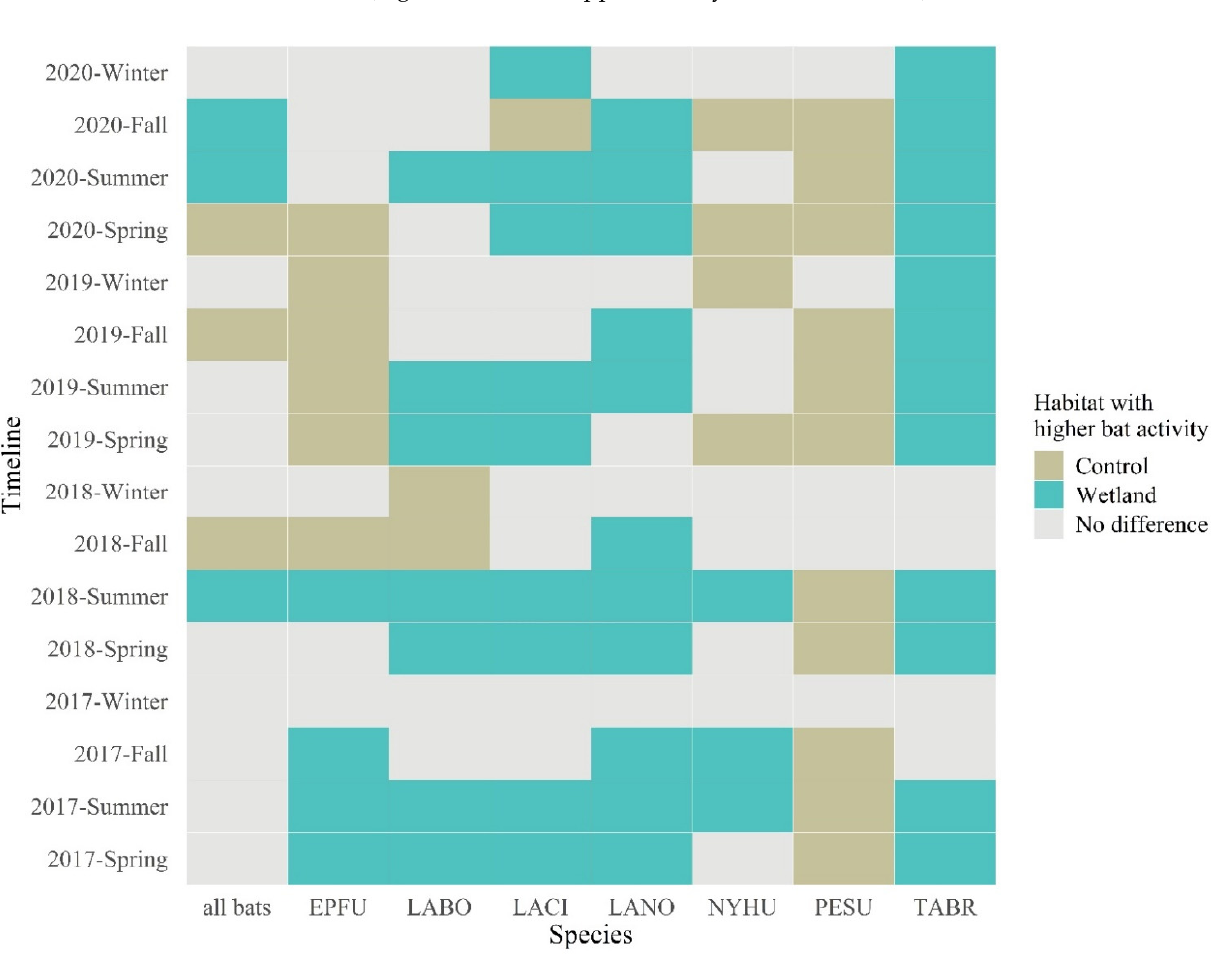
Figure 1. Tile plot showing in different seasons whether the open wetland or the open control had higher total and species- specific bat activity in the Peabody Park in Greensboro, North Carolina, USA. Statistical significance was determined by Wilcoxon tests. Species abbreviations in all figures: EPFU, Eptesicus fuscus ; LABO, Lasiurus borealis ; LACI, L. cinereus ; LANO, Lasionycteris noctivagans ; NYHU, Nycticeius humeralis ; PESU, Perimyotis subflavus ; TABR, Tadarida brasiliensis